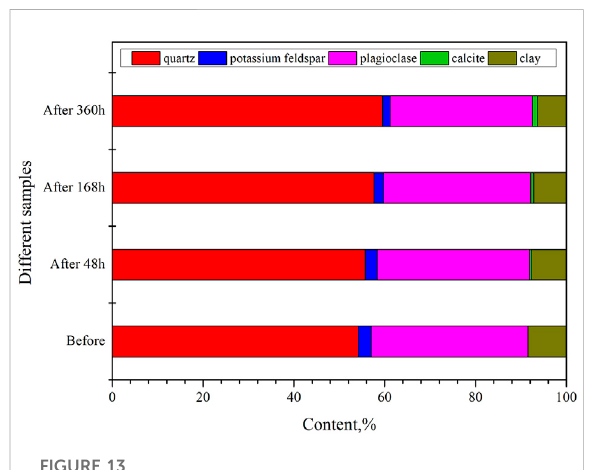
FIGURE 13 Mineral composition oftight sandstone changes after various supercritical CO 2 reaction times.